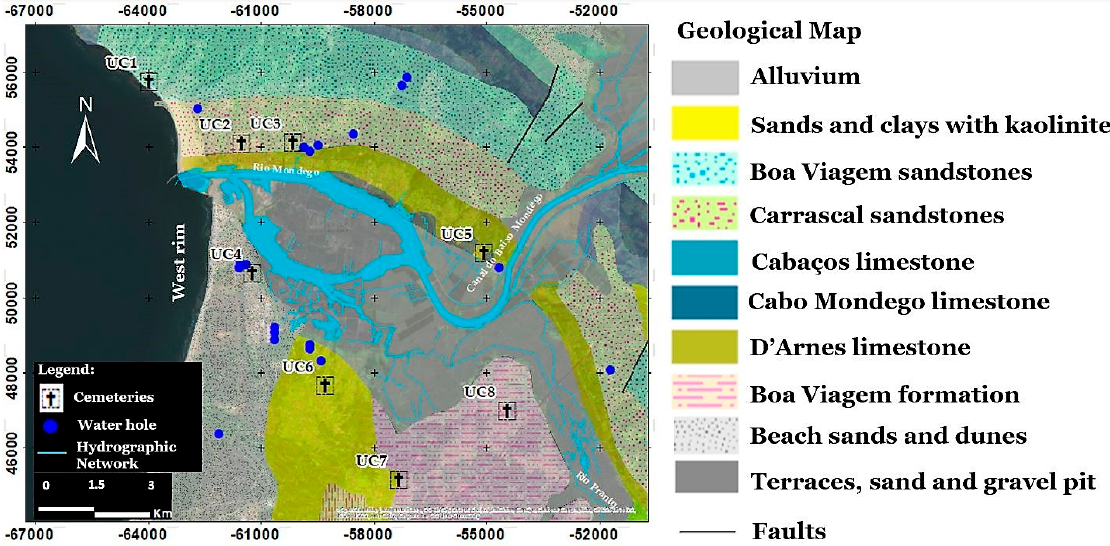
Figure 4. Geological map of the studied area.